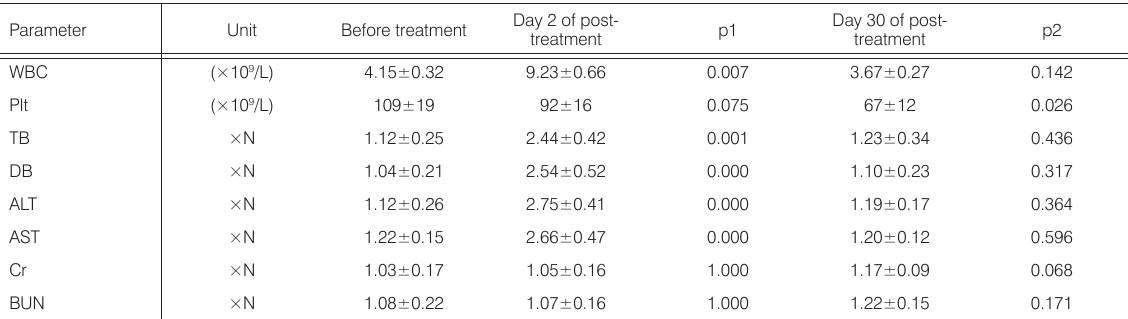
Table 3. Effects of combined treatment on hematology, liver and renal functions (mean ±